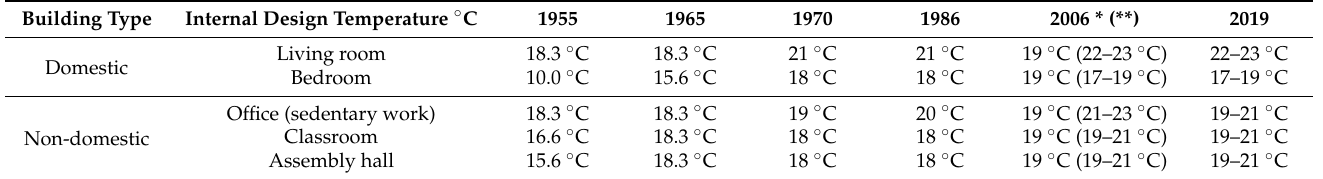
Table 1. Internal design temperatures through time in the UK (IHVE, 1955, 1965, 1970; CIBSE, 1986, 2006,